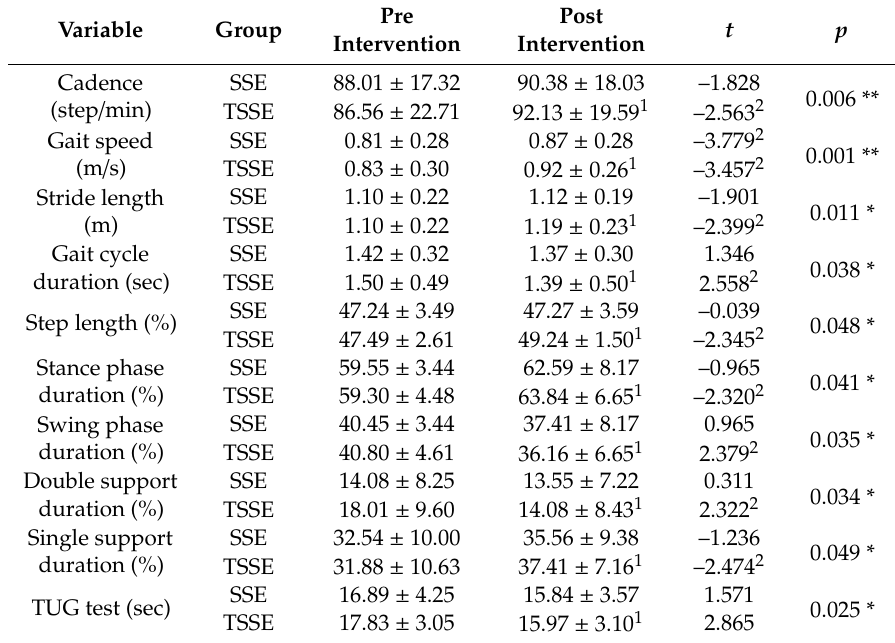
Table 2. Change in gait parameters and timed up-and-go (TUG)